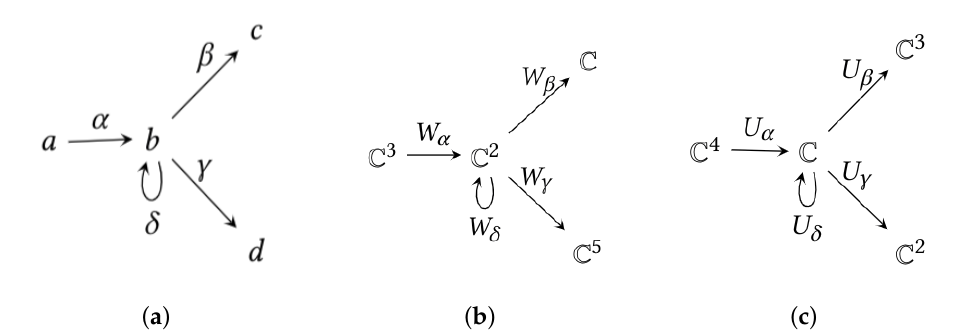
Figure 1. ( a ) A quiver Q with vertices V = { a , b , c , d } and oriented edges E = { α , β , γ , δ } , where the source and target maps are defined by s ( α ) = a , s ( β ) = b , s ( γ ) = b , s ( δ ) = b , t ( α ) = b , t ( β ) = c , t ( γ ) = d and t ( δ ) = b . ( b ) A quiver representation W over Q , where vertices a to d are complex 3D, 2D, 1D and 5D vector spaces, and W α is a 2 × 3 matrix, W β is a 1 × 2 matrix, W γ is a 5 × 2 matrix and W δ is a 2 × 2 matrix. ( c ) Another quiver representation U over Q , where a to d are complex 4D, 1D, 3D and 2D vector spaces, and U α is a 1 × 4 matrix, U β is a 3 × 1 matrix, U γ is a 2 × 1 matrix and U δ is a 1 × 1